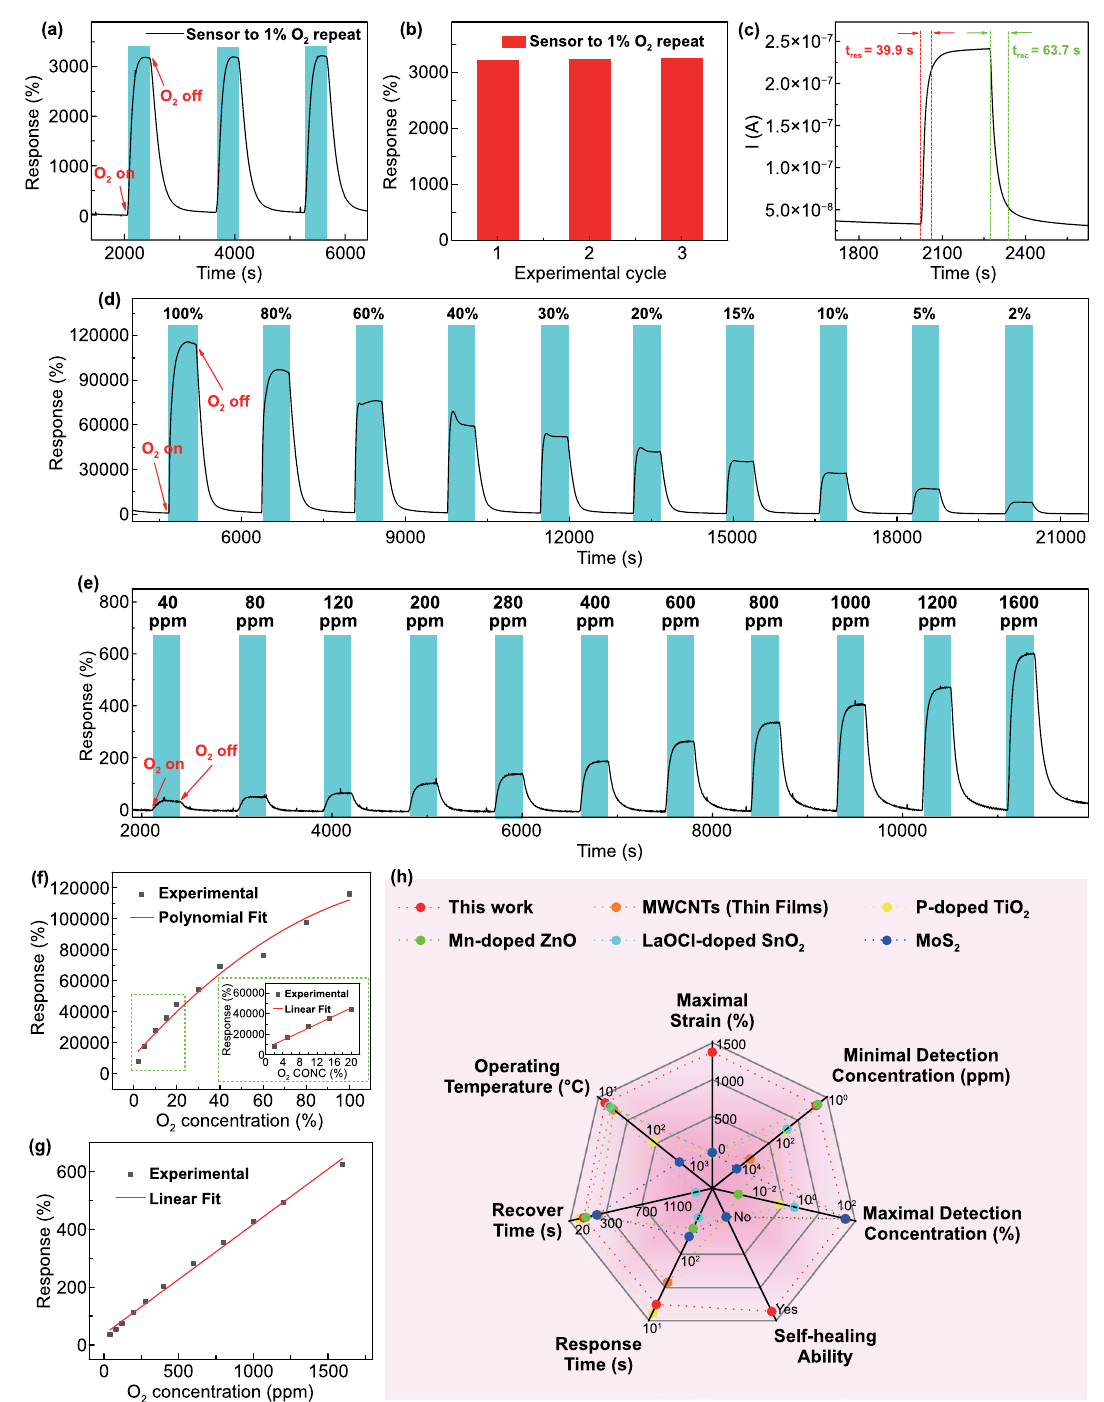
Fig. 2 O 2 sensing properties of the organohydrogel sensor. a Time-dependent response of the sensor to 1% O 2 in three experimental cycles. The blue and white areas represent the “on” and “off” states of test gas in the gas chamber. b Quantitative response extracted from a versus experi- mental cycle. c Investigation of the response and recovery time in the detection of 1% O 2 . d , e Time-dependent responses of the sensor upon exposure to O 2 with wide ranges of high (2-100%) and low (40-1600 ppm) concentrations, respectively. f The polynomial fit of responses versus O 2 concentration within 2%-100%. The green box in the inset shows a linear fit of response versus O 2 concentration from 2 to 20%. g The linear fit of responses versus O 2 concentration within 40-1600 ppm. h The radar chart comparing the performance of this O 2 sensor with that of other O 2